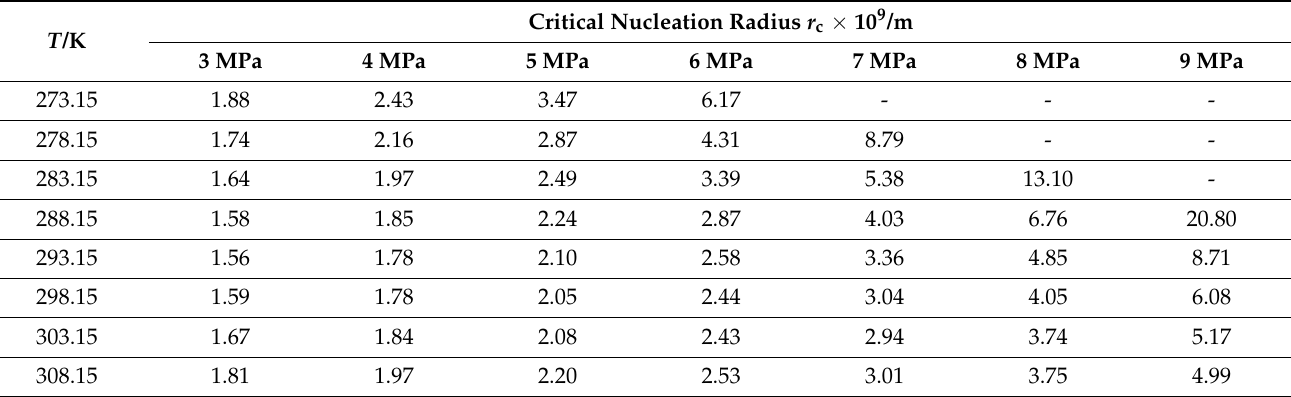
Table 3. Calculation results of critical nucleation radius of elemental sulfur in gas